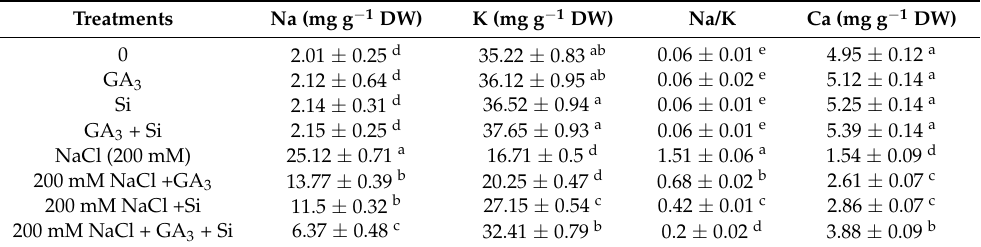
Table 4. Effect of gibberellic acid and silicon application on Na, K, Na/K and Ca of B. juncea cultivated under NaCl